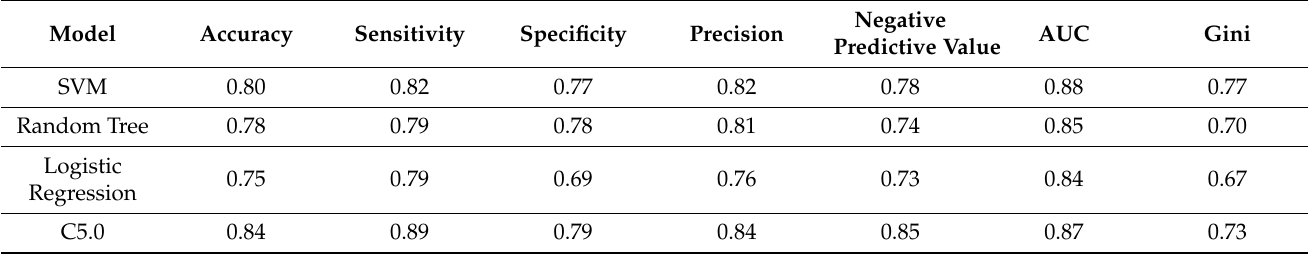
Table 3. Results of the classification performance of different machine-learning models using the working dataset.